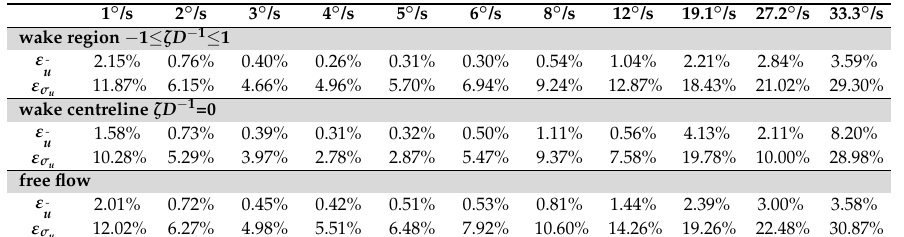
Table A2. Average wind speed and standard deviation error against the LES of RHI scans for different angular velocities, ω θ .